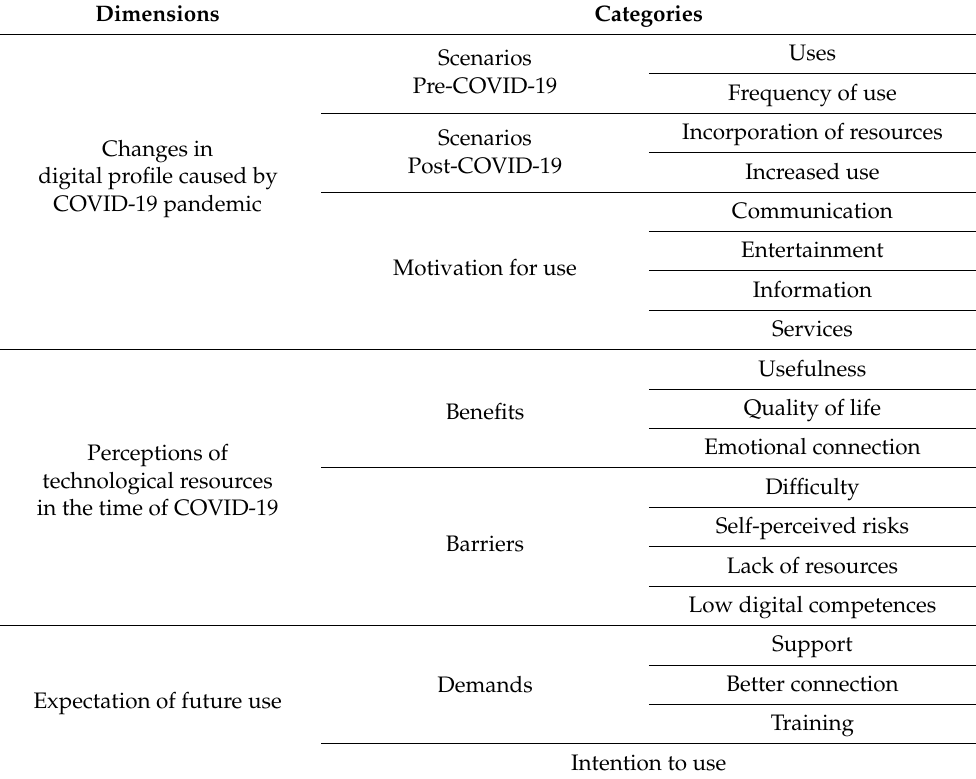
Table 1. Study dimensions and categories.